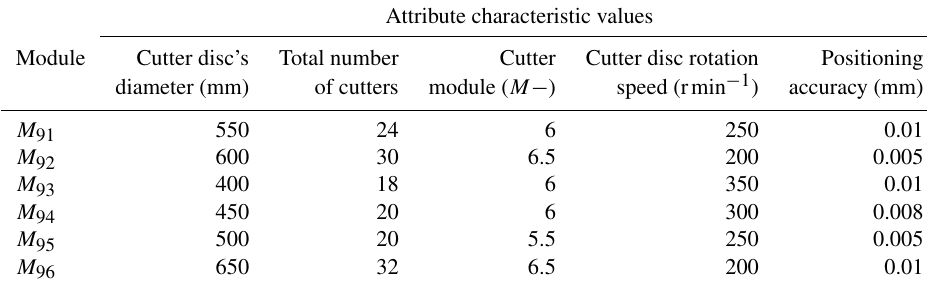
Table 3. Attribute characteristic values of the cutter disc module.